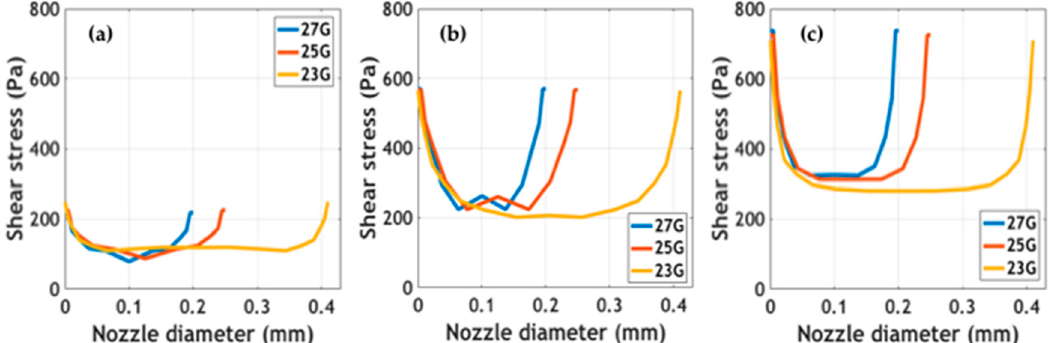
Figure 4. Shear stress profiles of the bioinks at different nozzle diameters and extrusion pressures: ( a ) 10 kPa, ( b ) 20 kPa, and ( c ) 60 kPa.